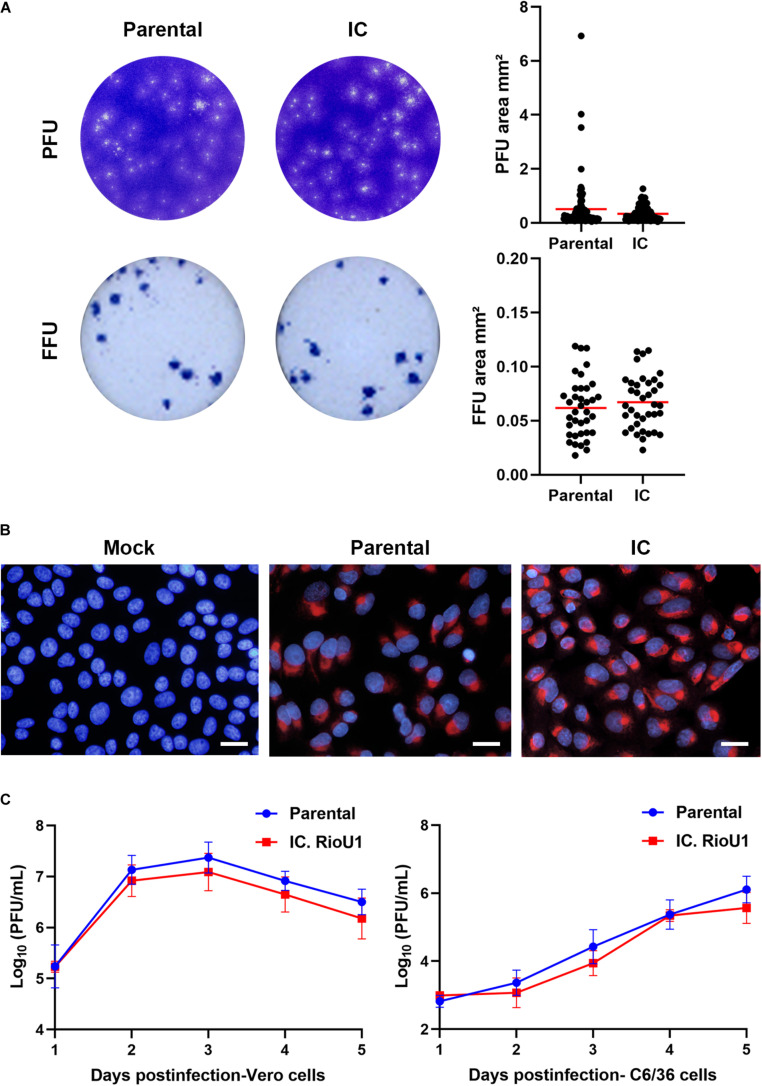
In vitro characterization of IC.RioU1 virus. (A) Viral plaque and focus morphology of the original isolate Rio-U1 (Parental) and the recovered infectious clone (IC. RioU1). On the right, the scatter plot graphs indicating the individual values for plaque and focus size. Red bars represent the mean of the data sample. (B) ZIKV E protein detection after 72 h of Vero cell infection with the parental and IC.RioU1. Infected cells were fixed and processed for immunolabeling with the pan-flavivirus antibody 4G2 (red) and staining cell nuclei with DAPI (blue) White bars indicate 100 μm. (C) Comparative studies of replication kinetics of the ZIKV isolate Rio-U1 and the infectious clone counterpart. Mammal Vero cells and mosquito C6/36 cells were infected with the parental and IC.RioU1 ZIKV at MOI of 0.02. Supernatants from infected cells were collected at indicated times post-infection and titers were determined by plaque assay. Each time point represents the mean ± SD of three independent experiments. No significant statistical difference was observed between both viruses (Unpaired T-test, Two tailed, p > 0.05).